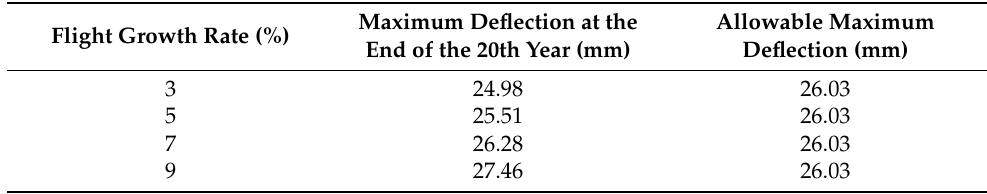
Table 7. The maximum deflection of the taxiway bridge mid-span considering the annual flight growth